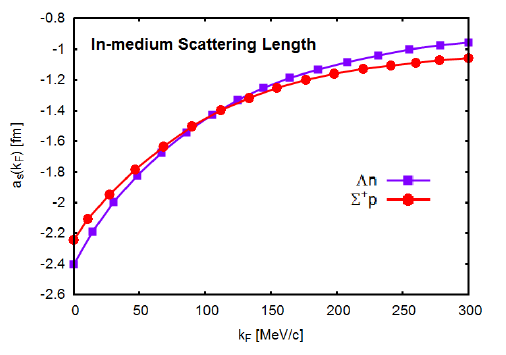
Figure 6. (Color online) Neutron star baryon fractions obtained with density dependent hyperon-vector meson coupling con- stants. The partial occupation numbers are shown as a func- tion of the neutron star radius. The hyperons are confined to a spherical shell R 1 < r < R 2 . Only Λ and Σ − hyperons contribute while the other octet hyperons are completely suppressed.